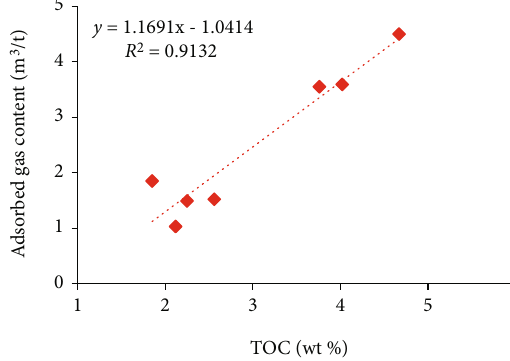
Figure 4: Relationship between TOC and adsorbed gas content of samples from Wufeng-Longmaxi Formation, JSB area in Fuling gas fi